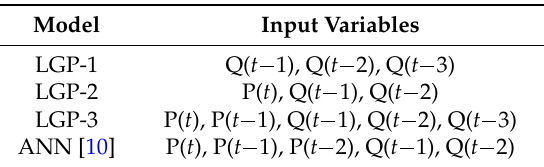
Table 1. Input variables included for LGP as a standalone application along with comparative ANN